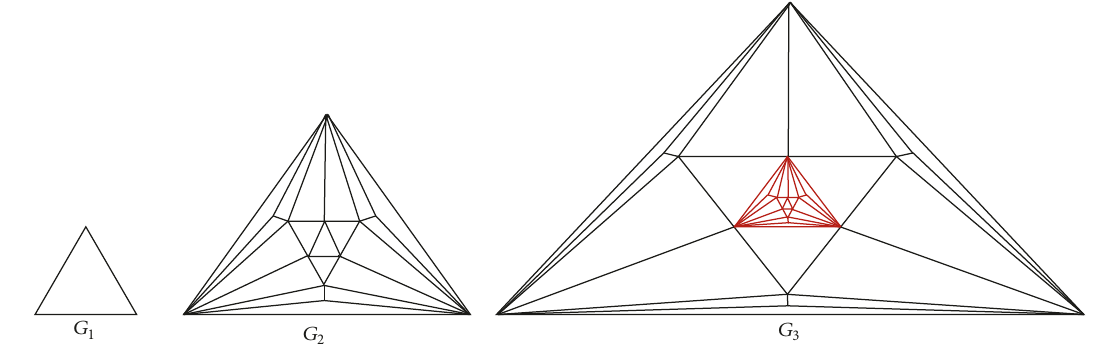
Figure 1: The first three graphs of 𝐺 𝑛